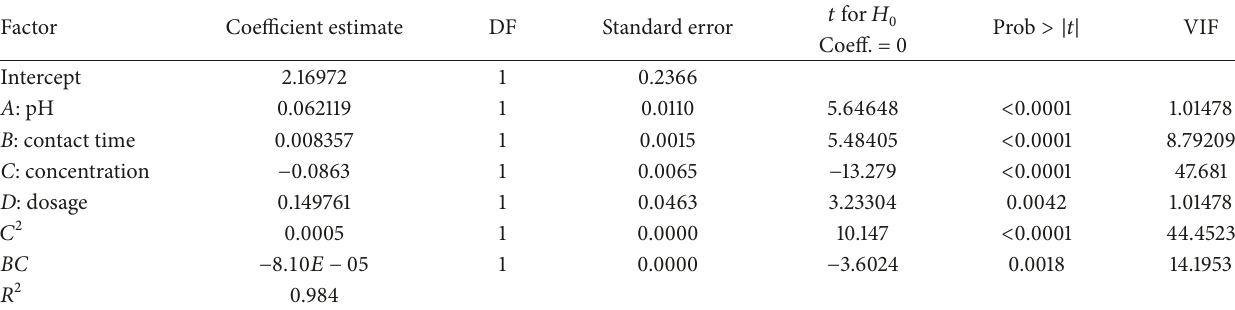
Table 3: Least squares regression data for Ca(II)